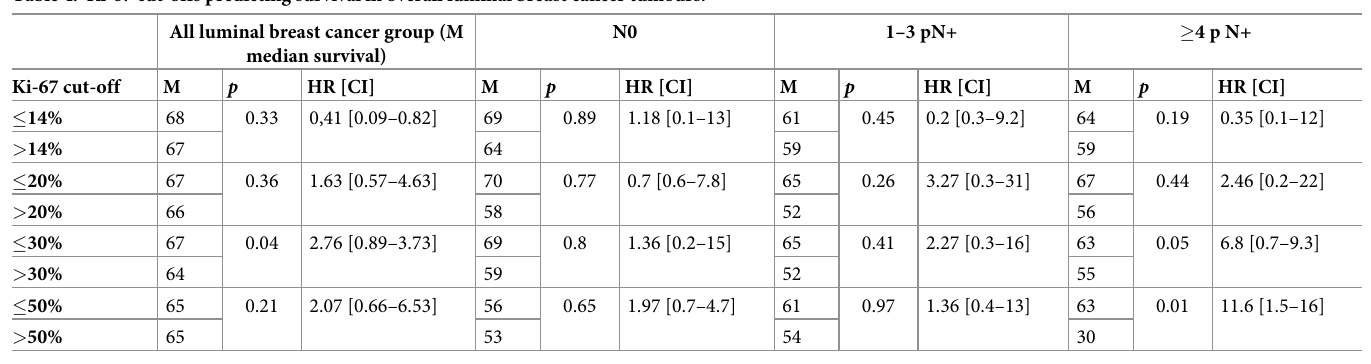
Table 4. Ki-67 cut-offs predicting survival in overall luminal breast cancer tumours. All luminal breast cancer group (M median